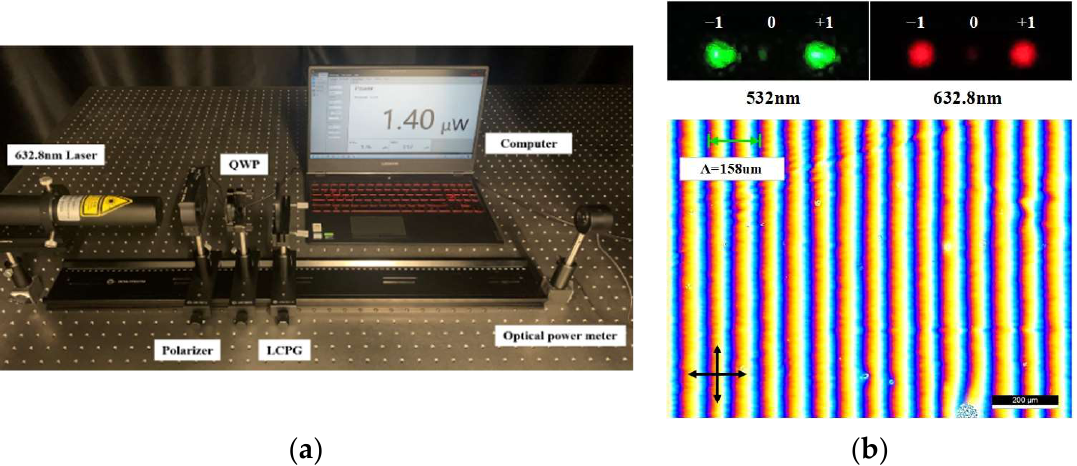
Figure 5. ( a ) Linear polarized light detection experimental device; ( b ) diffraction patterns of polarization grating and textures of LCPG observed under polarized microscope with black arrows showing polarizer and analyzer direction.